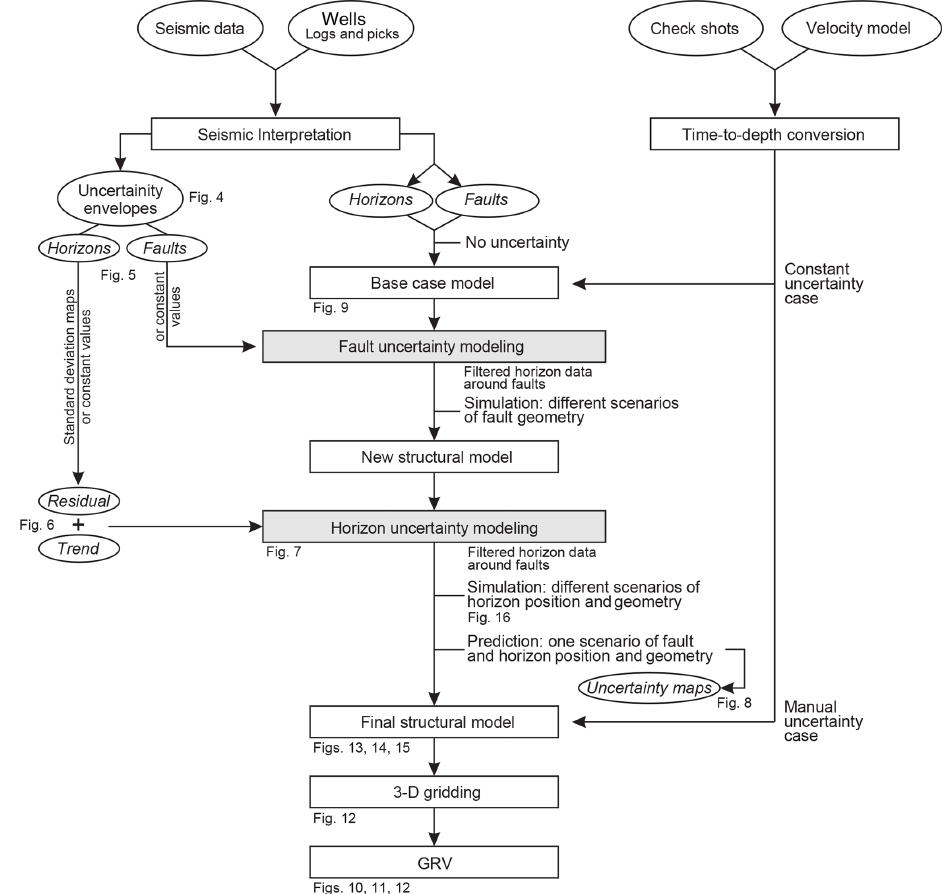
Figure 3. Diagram showing the steps of the workflow applied for both the manual and the constant uncertainty modeling cases. An initial structural model is constructed using the best-estimate interpretation of the seismic data. The fault uncertainty, first, and the horizon uncer- tainty, later, are added into the model to obtain a final structural model reproducing different scenarios of fault and horizon geometry and position. The scenarios are finally compared in terms of gross rock volumes (GRV) to evaluate the impact of the structural uncertainty. The numbers of figures illustrating the modeling steps are